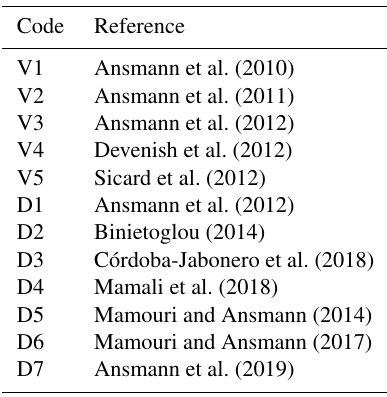
Table 1. The code used in Fig. 3 and the respective